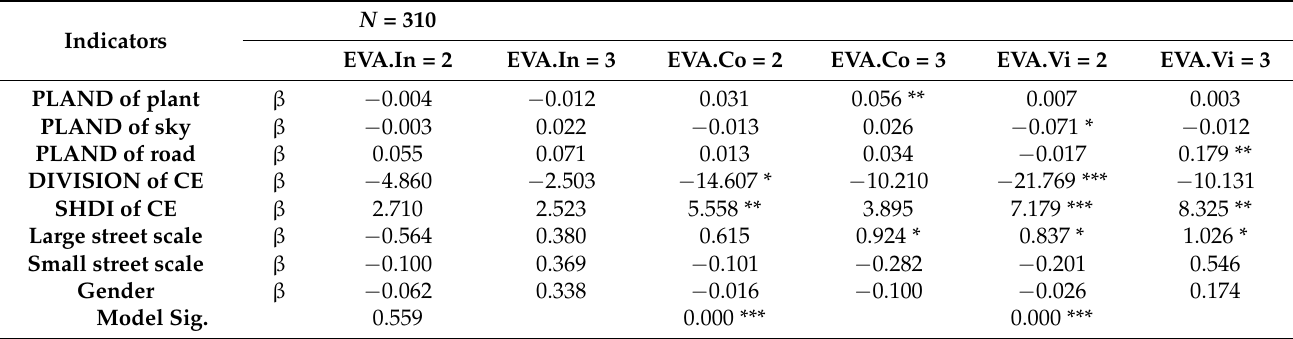
Table 6. Results of the multiple logistic regressions of the constituent-element characteristics on the subjective evaluation indicators.